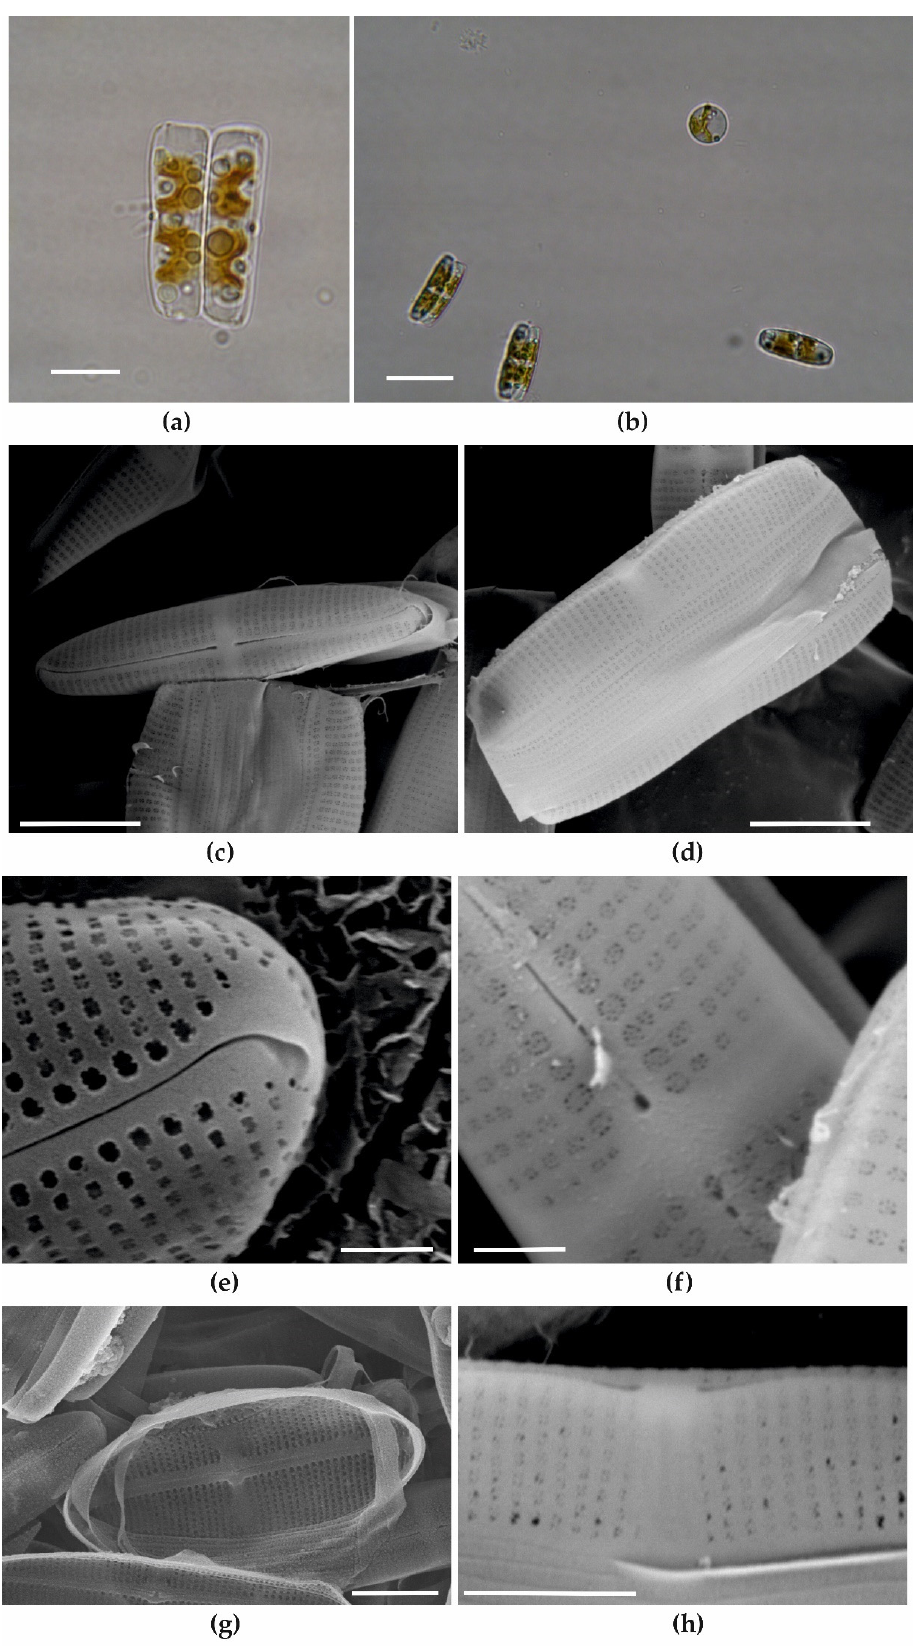
Figure 4. Light ( a , b ) and scanning electron images ( c – h ) of Craspedostauros zucchellii IMA088A. Scale